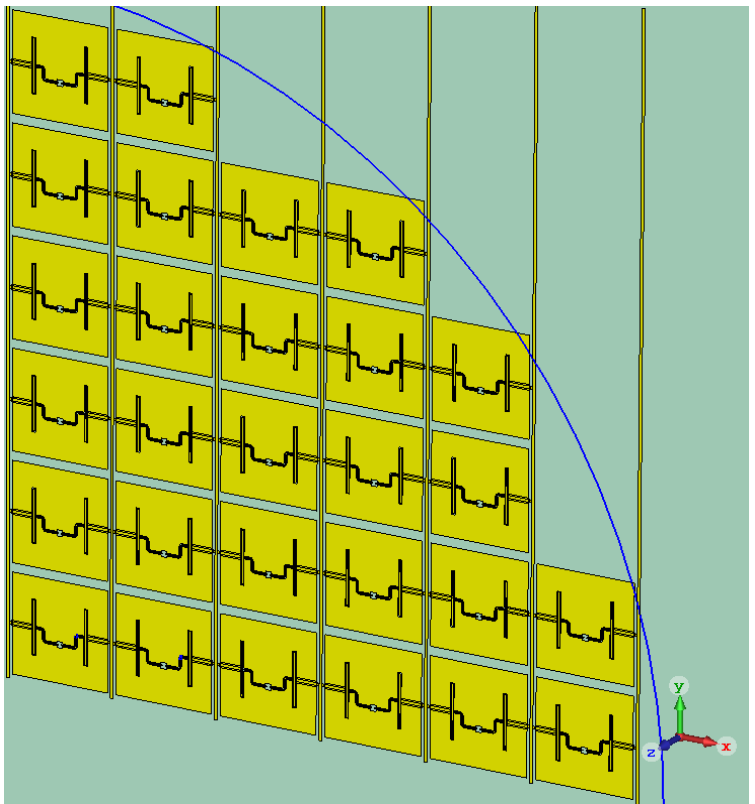
Figure 6. A quarter of the antenna cells array, used for numerical modelling with symmetry planes. Blue circle shows the 4.5 mm waveguide feedhorn opening. The diameter of this rounded array should not exceed 4.5 mm. It is because of a predefined configuration of a back-to-back feedhorn, which will be used with this system. The optimal antenna cells number to fill this feedhorn configuration is